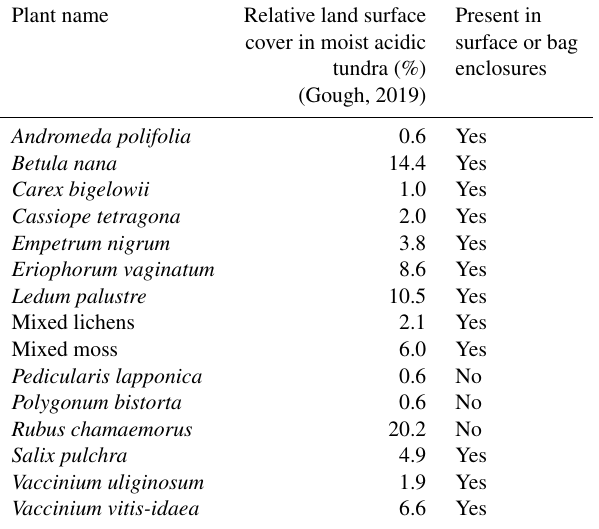
Table 1. Year 2017 median relative percent cover of plant species in moist acidic tundra Long-Term Ecological Research (LTER) ex- perimental control plots at Toolik Field Station. The last column indicates whether plant species were present in surface or bag en- closure experiments in this